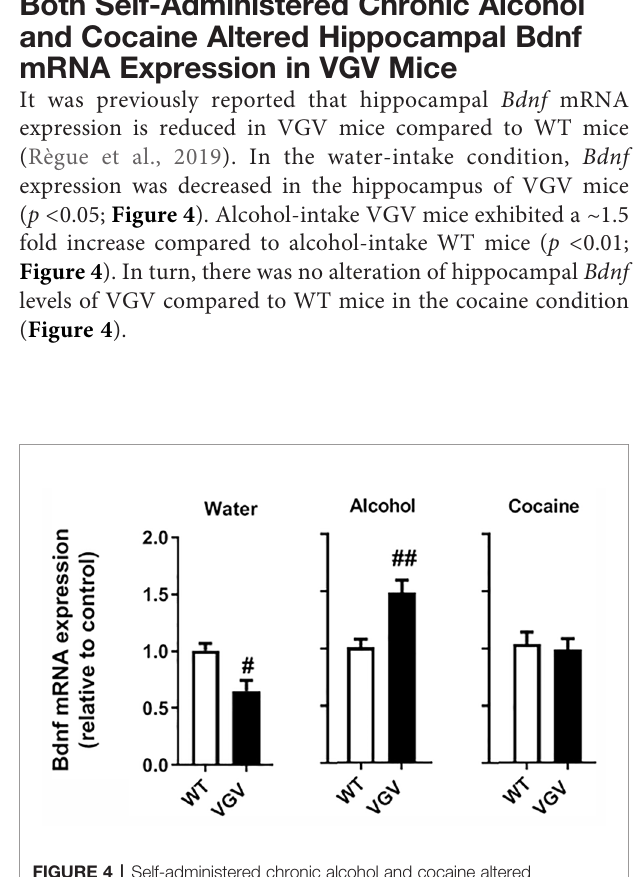
FIGURE 4 | Self-administered chronic alcohol and cocaine altered hippocampal Bdnf mRNA expression in VGV mice. Bdnf mRNA expression was decreased in VGV mice compared to WT mice ( t (6) = 3.01, p < 0.05). Alcohol-treated mice exhibited a ~1.5 fold increase compared to alcohol- treated WT mice ( t (9) = 3.51, p < 0.01). In the cocaine condition, VGV mice did not differ from WT mice. Data are mean expression levels ± S.E.M. normalized to WT mice. VGV vs WT mice (water-treated WT or water treated VGV mice, n = 4; alcohol-treated or alcohol-treated VGV mice, n = 5 – 6; cocaine-treated WT mice, n = 8; cocaine-treated VGV mice, n = 12, # p <0.05; ## p